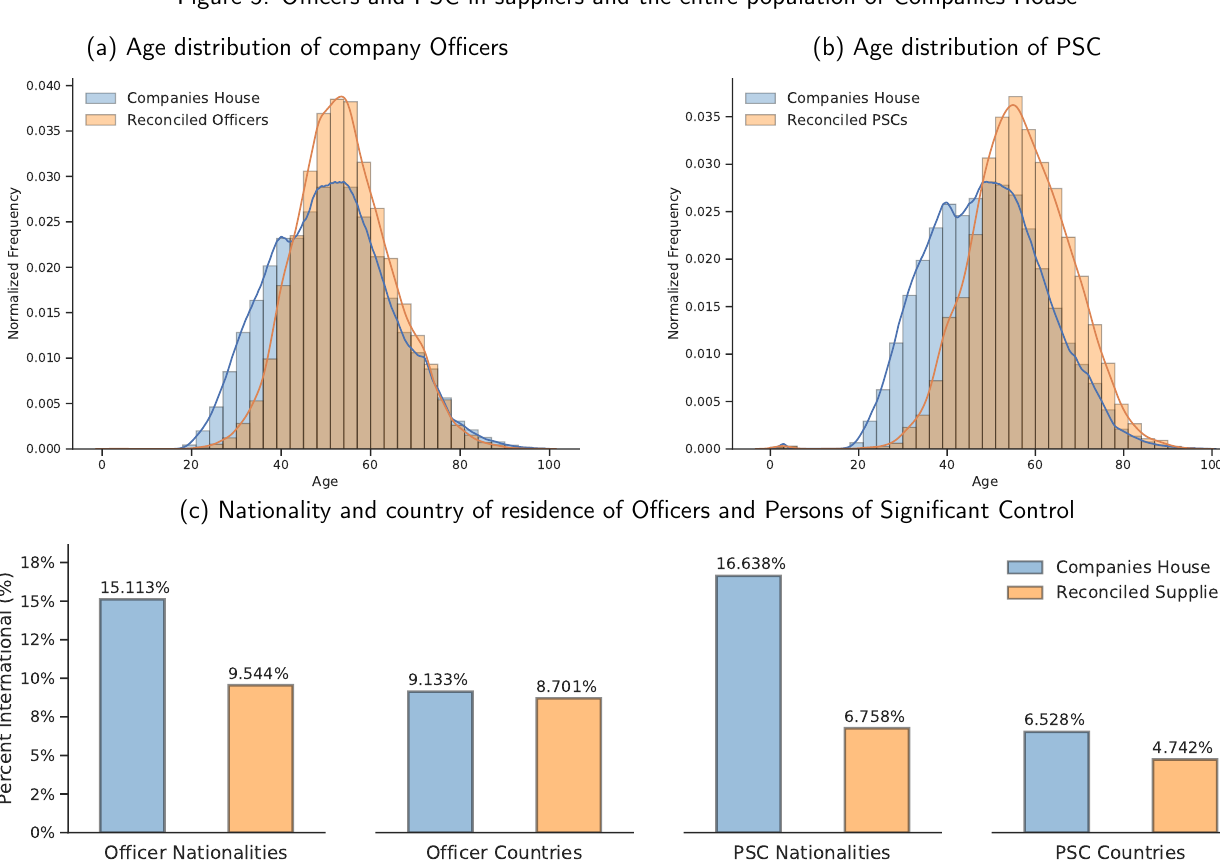
Figure 5: Officers and PSC in suppliers and the entire population of Companies House